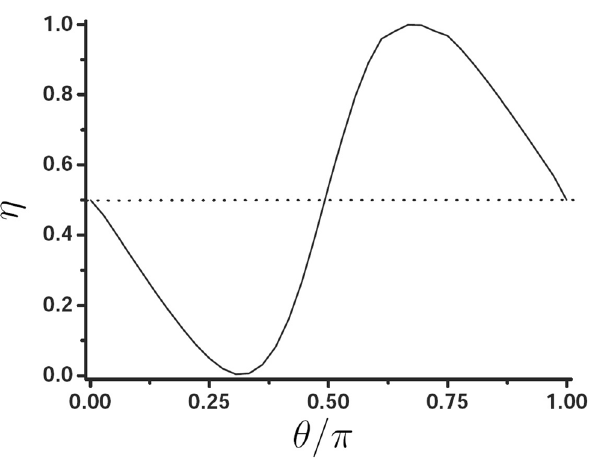
Figure 5. Spin separation as a function of polarization angle θ